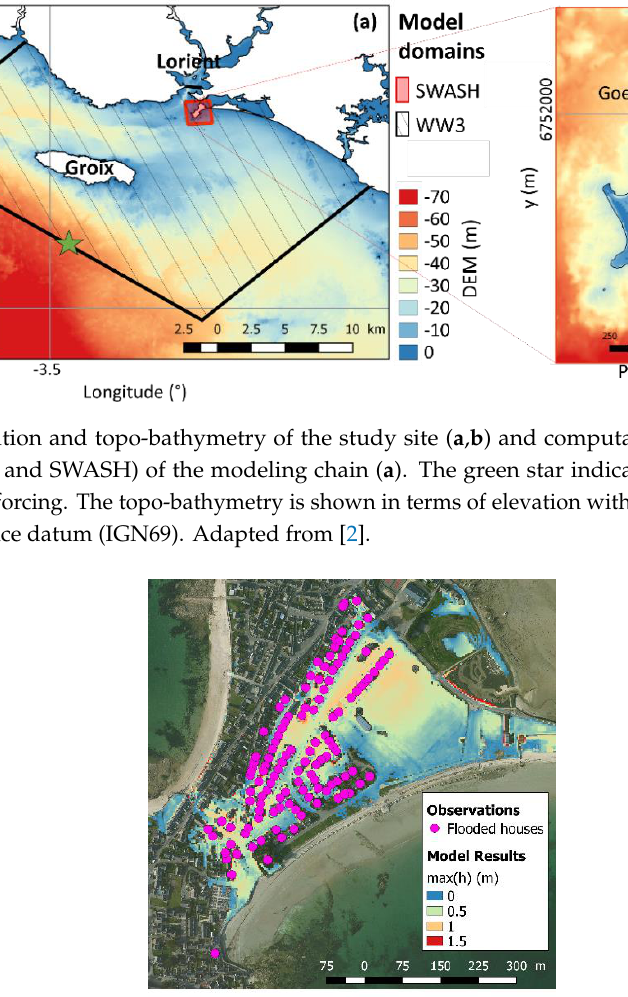
Figure 2. Model validation: maximal simulated water depth and observed flooded houses for the Johanna event. Adapted from Idier et al. (2020).